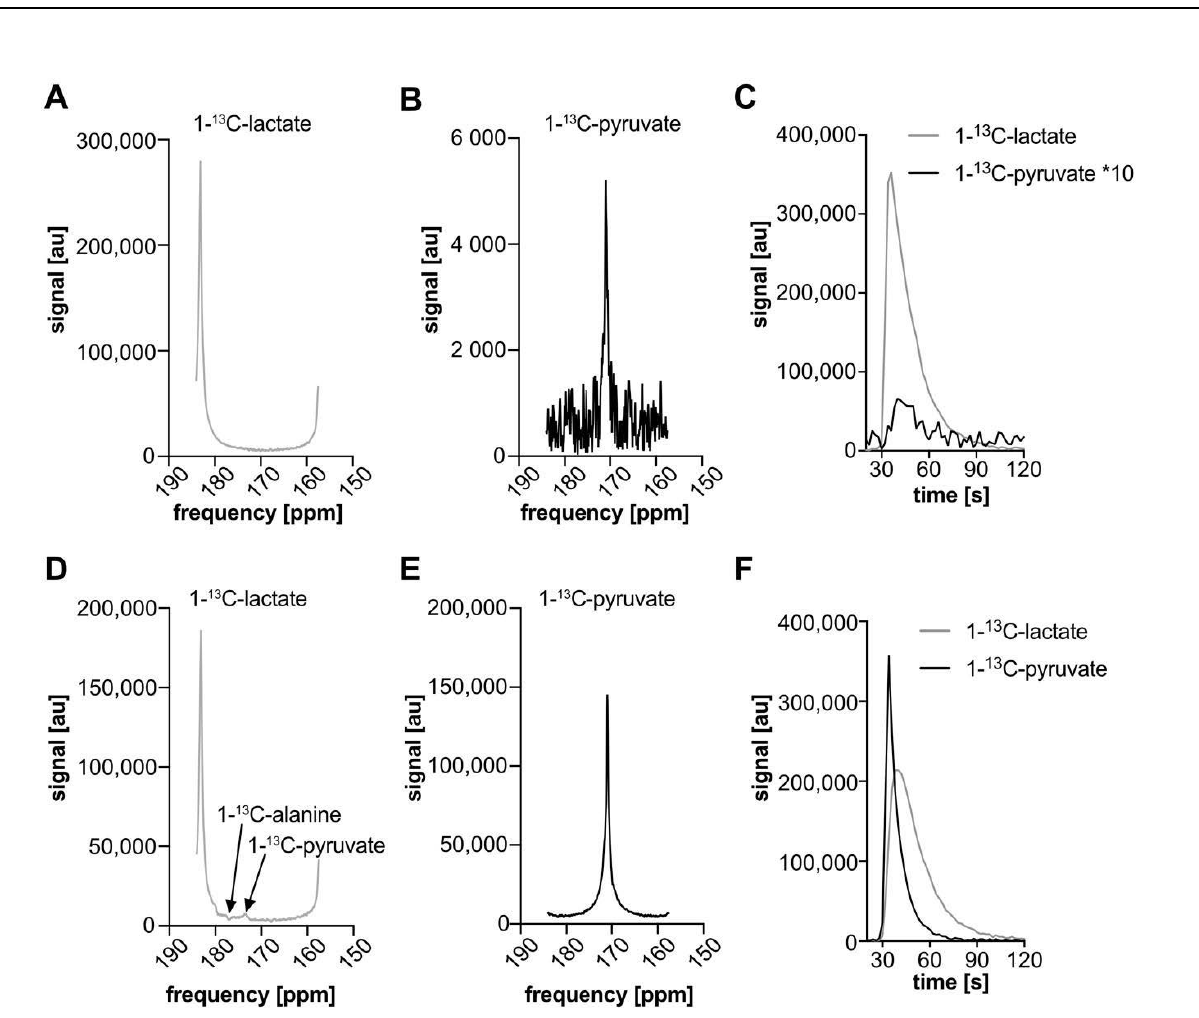
Figure 3. Magnitude spectra ( A , B , D , E ) and time courses ( C , F ) of hyperpolarized [1- 13 C]pyruvate ( B , E ) and [1- 13 C]lactate ( A , D ) acquired with narrow bandwidth (250 Hz) alternating-frequency excitation slice-selective spectroscopy in rat subcuta- neous tumors at 7 T (representative results of one rat out of three measurements). Spectra were summed over 15 frames (30 s) surrounding the peaks. After [1- 13 C]lactate injection ( A – C ), a strong lactate signal (near 183.5 ppm) and weak [1- 13 C]pyruvate signal (near 171 ppm) are seen. The pyruvate-selective excitation has eliminated the background signal tail from the lactate peak (Figure 2C). After [1- 13 C]pyruvate injection ( D – F ), both pyruvate and lactate show strong signal with narrow bandwidth excitation. Small ripples in ( D ) correspond to [1- 13 C]alanine and [1- 13 C]pyruvate excited in the body of the rat by the lactate-targeted excitation, at shifted frequencies due to shim variations outside the